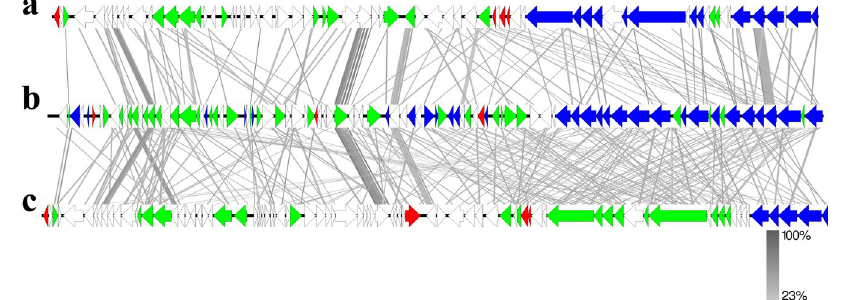
Figure 4. Comparison of ( a ) Burkholderia virus E125 (AF447491), ( b ) Paraburkholderia terrae phage ɸ 437,and ( c ) B. pseudomallei phage 1026b (AY453853). Color boxes are indicated as previous figure with additional. Comparison percentage was generated using BLAST + 2.4.0 (tBLASTx with cutoff value 10 − 3 ) and